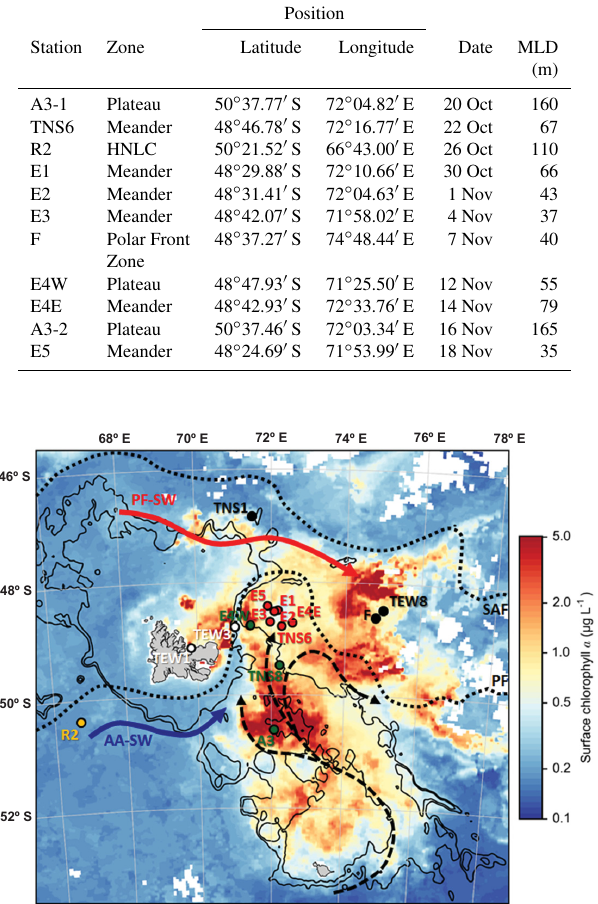
Figure 1. Map of the KEOPS-2 cruise area (Indian sector of the Southern Ocean) showing the locations of the stations. Coloured dots represent the different regions discussed in this study: yellow for HNLC, green for plateau, red for meander, black for polar front, and white for coastal stations. The general surface circulation (from Park et al., 2014) is shown with arrows; the blue arrow is the Antarc- tic Surface Waters, and the red arrow is the Polar Front Surface Wa- ter. The Polar Front and the Sub-Antarctic Front are represented by black dotted lines. The colour represents the detailed map of the satellite-derived surface chlorophyll a concentration (MODIS level 3 product) averaged over the cruise period, and black lines are 500 and 1000m